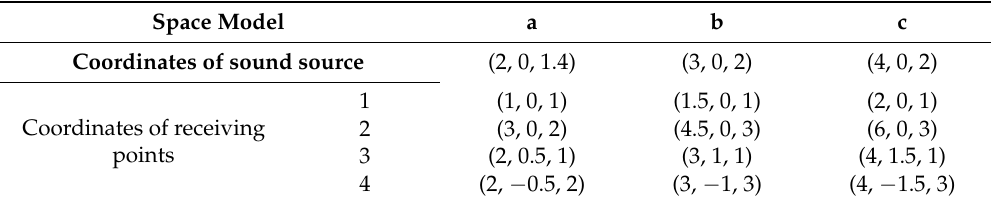
Table 4. The positions of sound source and receiving points in closed-space